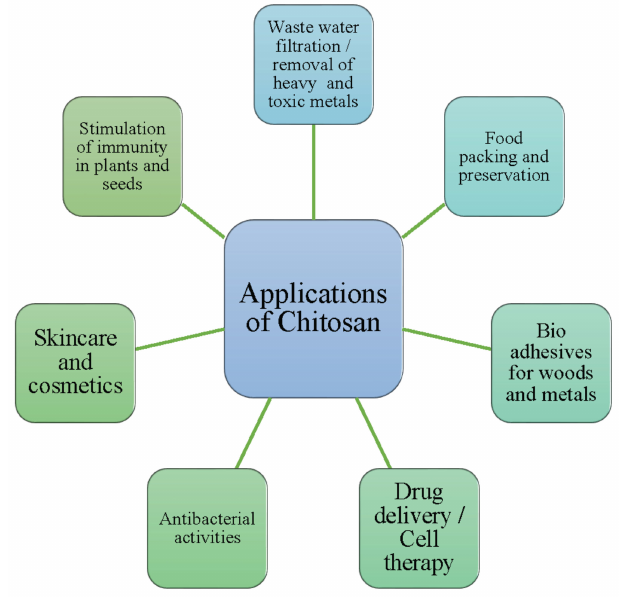
Figure 1. Various applications of